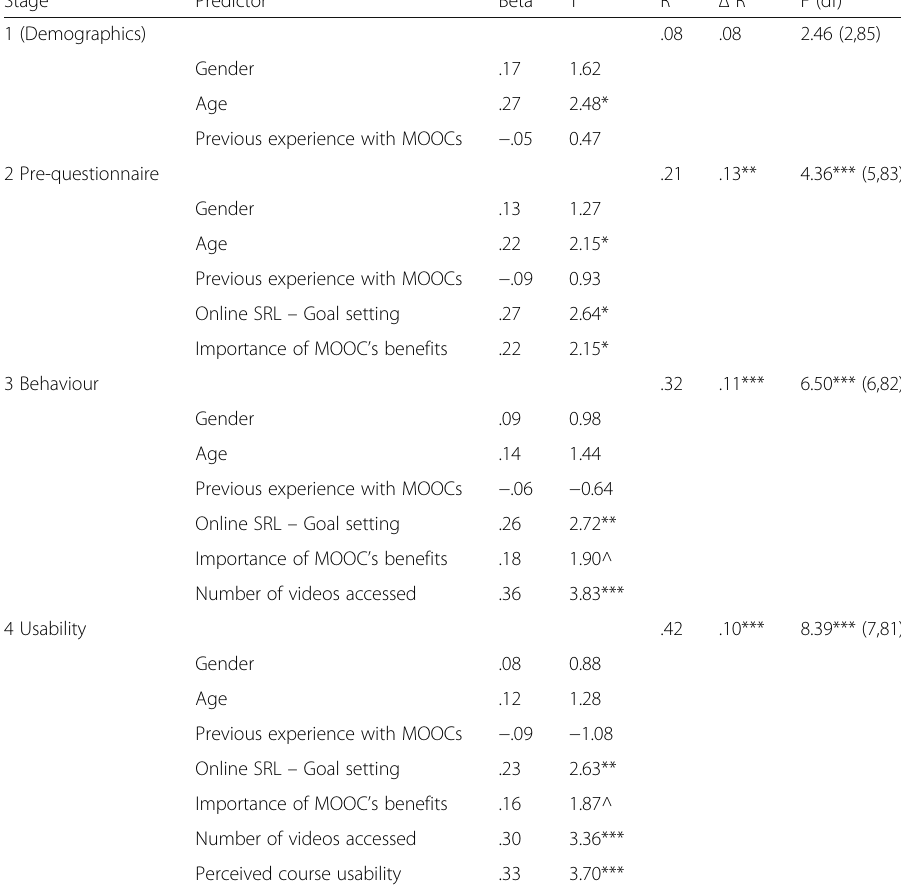
Table 2 Stepwise linear regression predicting learner satisfaction, performed in four stages Stage Predictor